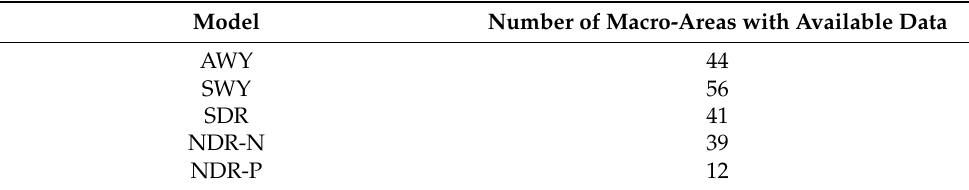
Table 12. Number of macro-areas with data available for the parametric consistency analysis. Model Number of Macro-Areas with Available